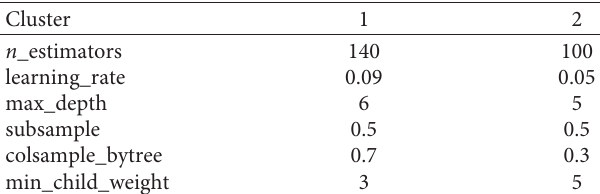
Figure 3: Distributions of clearance time. (a) Original clearance time distribution of cluster 1. (b) Original clearance time distribution of cluster 2. (c) Log-transformed clearance time distribution of cluster 1. (d) Square-transformed clearance time distribution of cluster 2. Table 4: The optimal parameters in XGBoost. Table 5: Prediction results for different